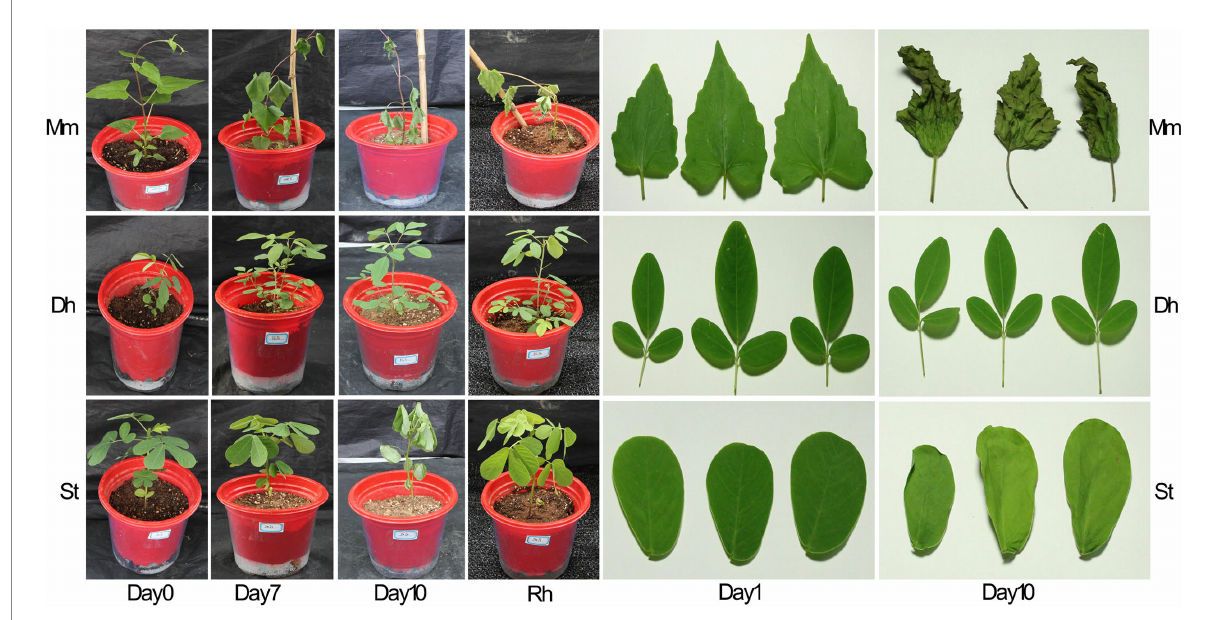
FIGURE 5 Changes of plant phenotype and leaf phenotype of two replacement forage legumes and M. micrantha under drought stress. Mm: M. micrantha ; Dh: D. heterocarpon ; St: S. tora ; Rh: